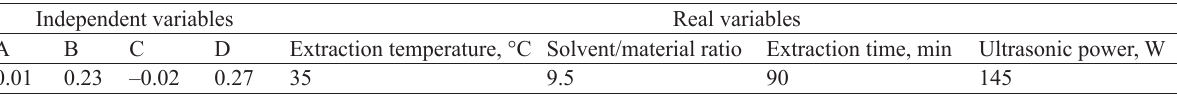
Table 5 The values of the independent and real variables Independent